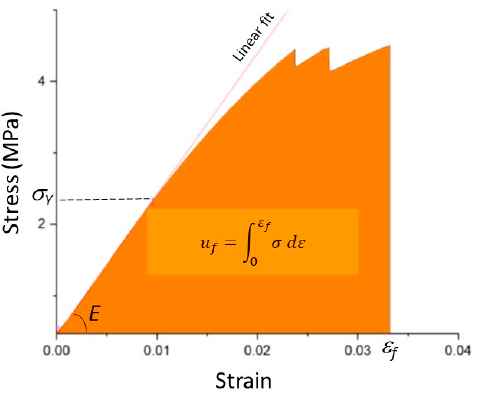
Figure 3. Representative true stress–strain response of structure A5 showing the calculation of the elastic modulus E , yield strength σ Y , strain at fracture ε f , and strain energy density at fracture u f .